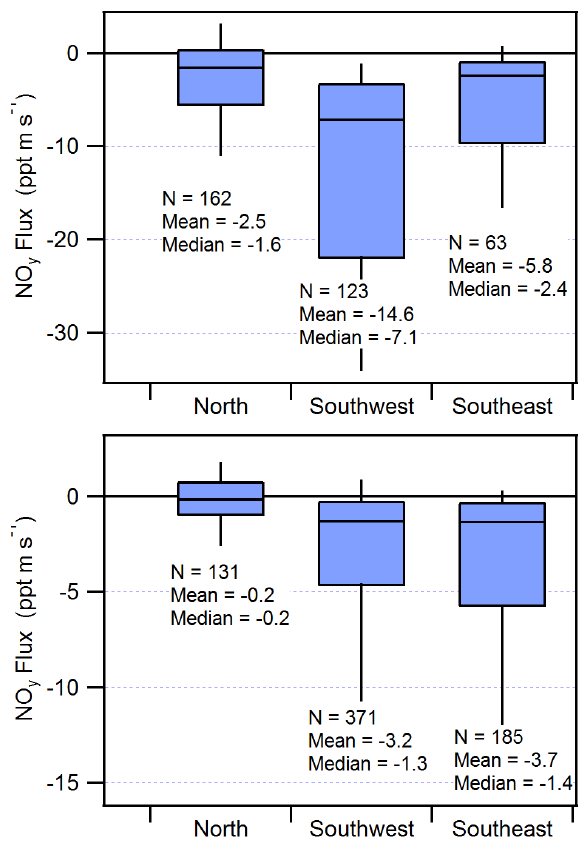
Fig. 11. Box-and-whisker plots of NO y flux observations (pptms − 1 ), organized by observed wind direction at (a) PROPHET and (b) HFWR. Boxes represent the 25th to 75th percentiles, and whiskers are drawn to the 10th and 90th